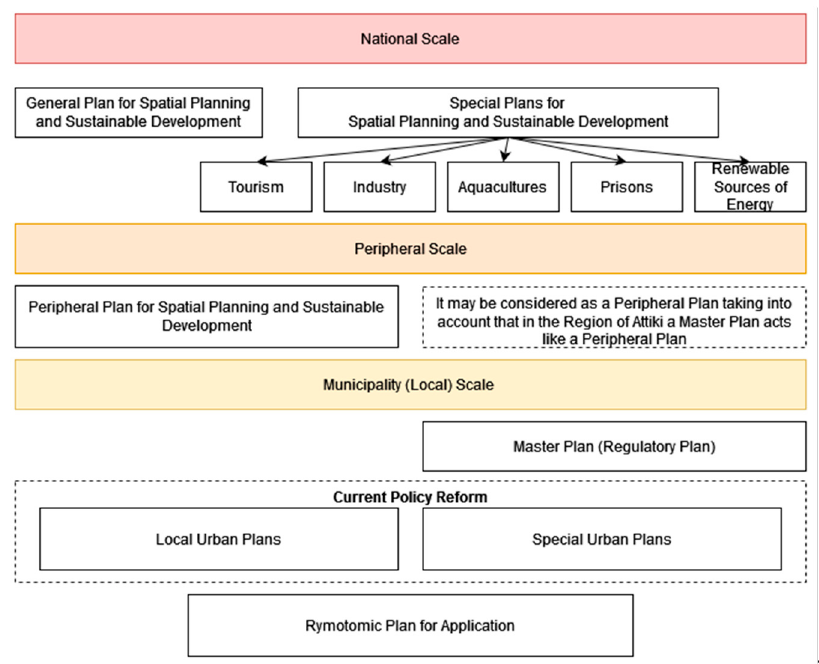
Figure 4. Diagrammatic presentation of the national approved spatial plans and the local (Peripheral and Municipality) level plans.